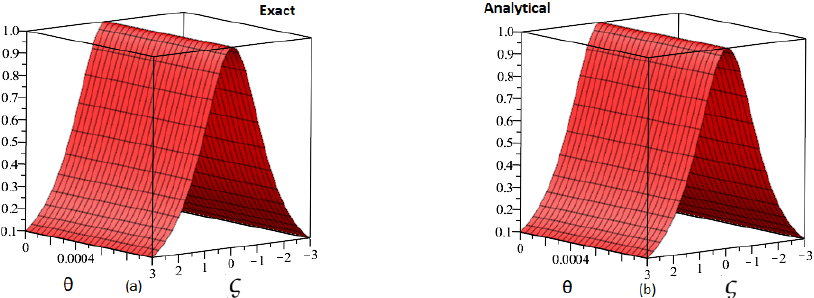
Figure 1. The profile of both the exact solution ( a ) and obtained solution ( b ) are considered.